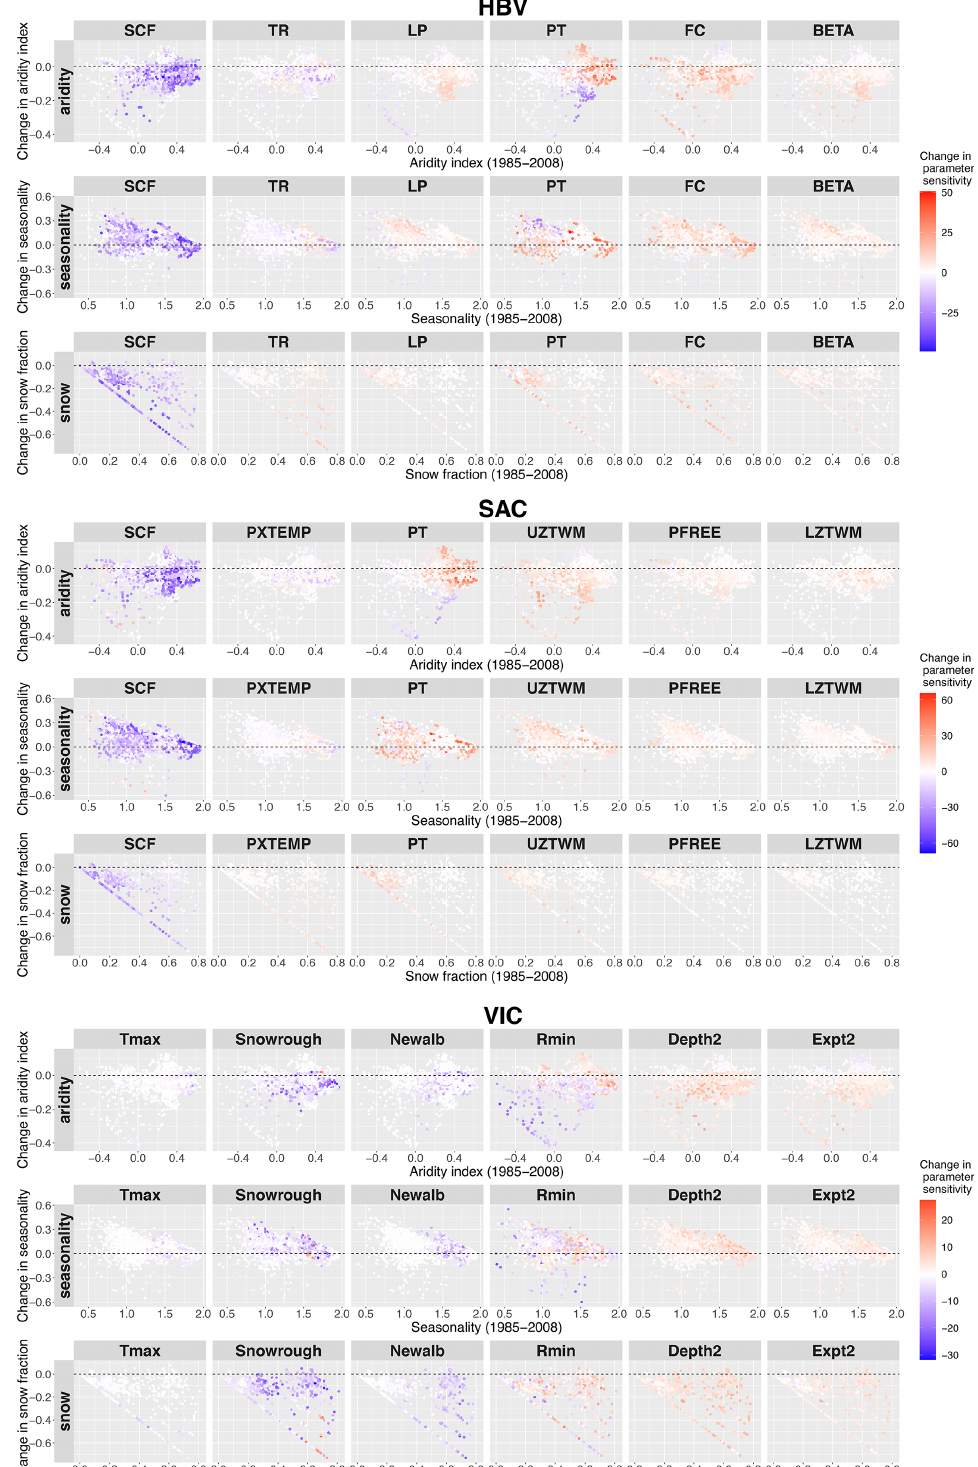
Figure 5. Change in parameter sensitivity vs. historical climate indicators and change in climate indicators for 605 basins. The climate indicators are determined for all three GCMs. Displayed are aridity index ( − 1 highly arid, + 1 highly humid), seasonality, and fraction of precipitation falling as snow, as defined by Knoben et al. (2018). Parameter sensitivity for the historical period is expressed in dot size, change in parameter sensitivity in colour: red indicates an increase in sensitivity, blue a